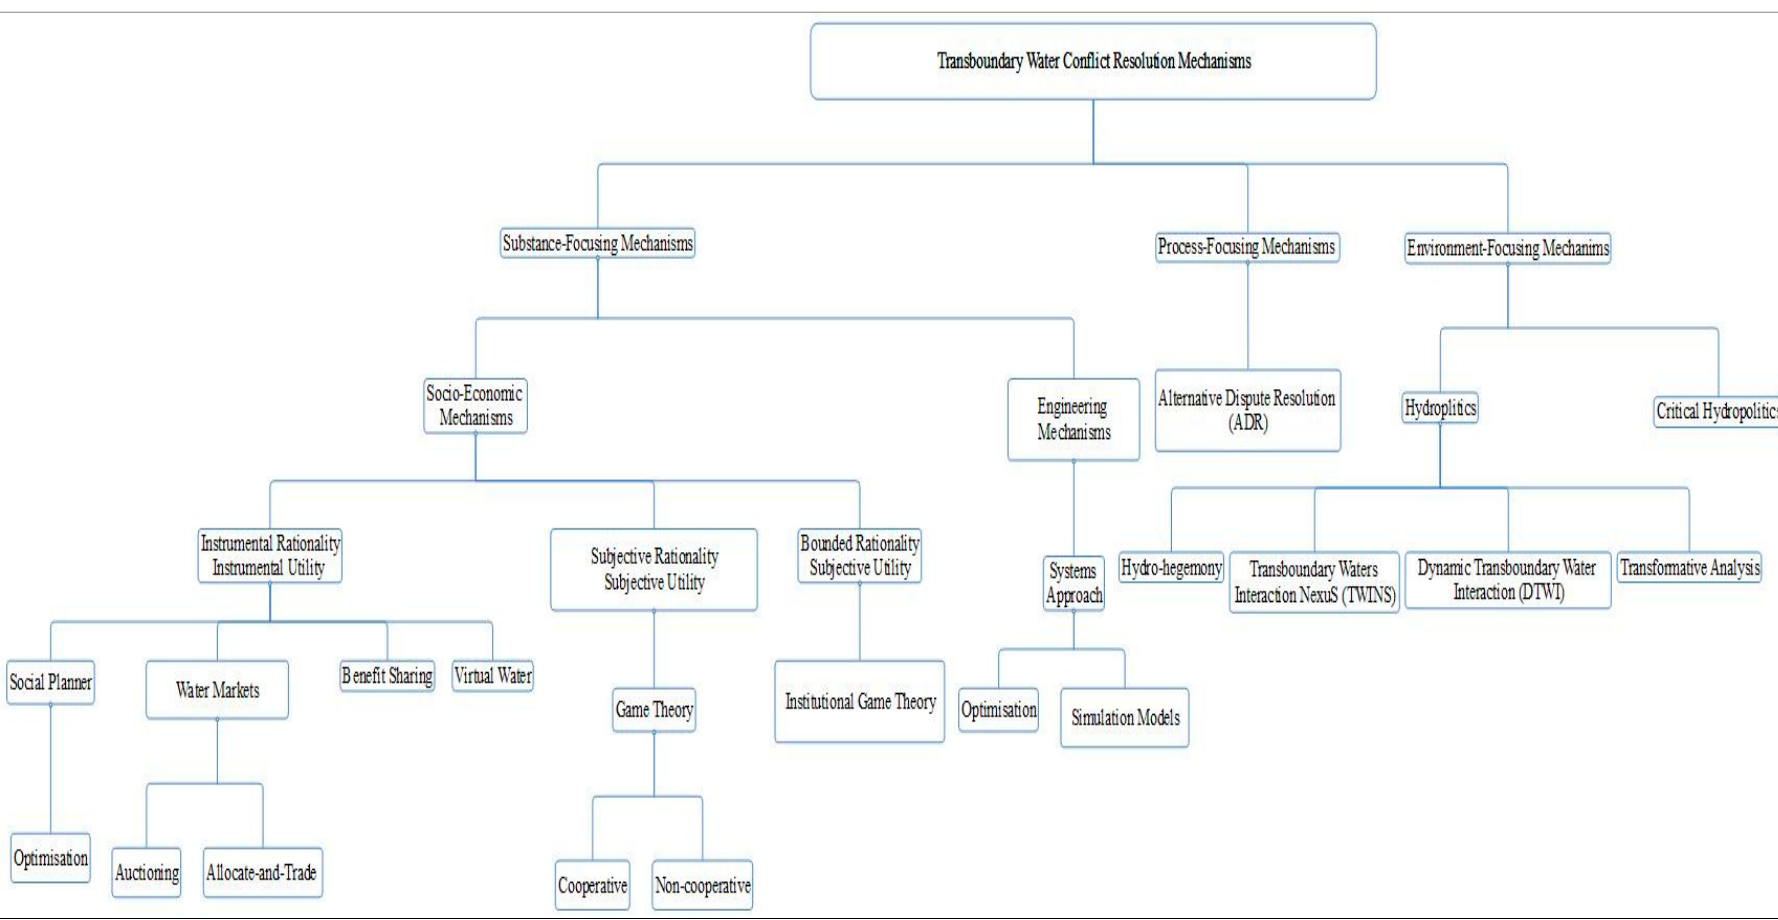
Figure 12. Transboundary Water Conflict Resolution Mechanisms—self-elaborated.